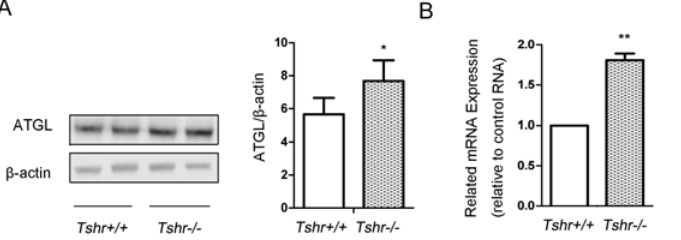
Figure 1. ATGL expression in visceral adipose tissues of Tshr-/- mice increased compared to that of Tshr+/+ mice. The epididymal adipose tissue was frozen in liquid nitrogen. Protein and mRNA were extracted according to the methods described before. (A) The protein expression levels of ATGL in the white adipose tissues of the Tshr-/- mice and Tshr+/+ mice were detected by Western blotting. The relative ATGL protein levels were quantified by densitometry and normalized with β -actin. (B) The mRNA levels of ATGL in the white adipose tissue of the two types of mice were determined by real-time PCR and normalized with actin. The relative values representing the ATGL mRNA levels in the Tshr-/- mice are reported as fold changes relative to those of the Tshr+/+ mice. The data are from 4 independent experiments and are presented as the mean (cid:2) SD. ** p < 0.01 versus Tshr+/+ mice. * p < 0.05 versus Tshr+/+